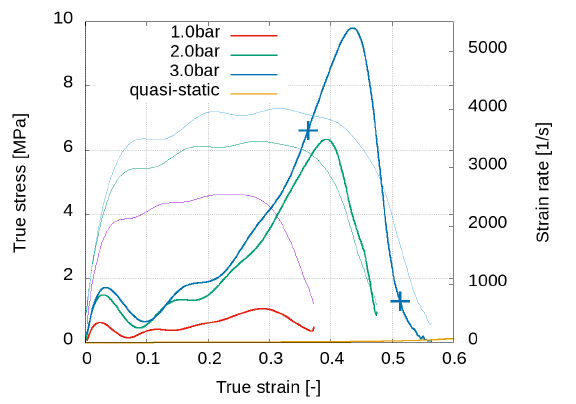
Figure 7. Stress-strain curves and strain-rate evolu- tion for group of ordnance gelatin specimens.